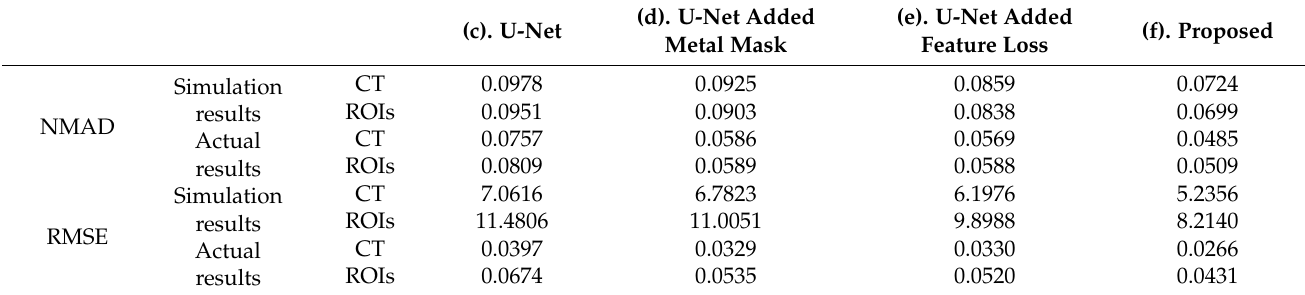
Figure 12. Actual results of head phantom, where the first row is the sinogram, the second row is the FBP reconstruction results, and the third row is an enlarged view of the ROIs. The display window of sinogram is (0, 1). The display window of CT and ROIs is ( − 0.01, 0.025). Table 5. RMSE and NMAD results of reconstructed images from the simulation